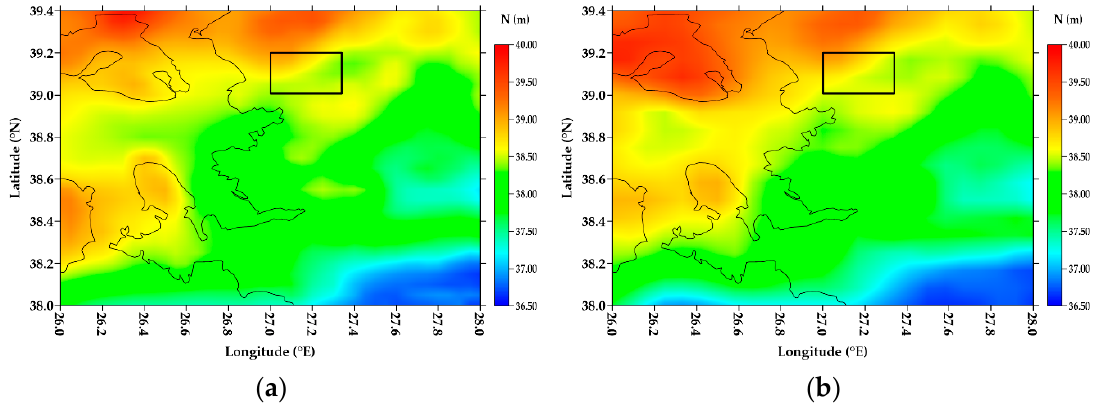
Figure 13. Geoid model surfaces, used in validation of local geoid models generated with Photogrammetric methods. ( a ) Regional geoid model (TG03) surface; ( b ) global geopotential model (EIGEN6C4) surface.